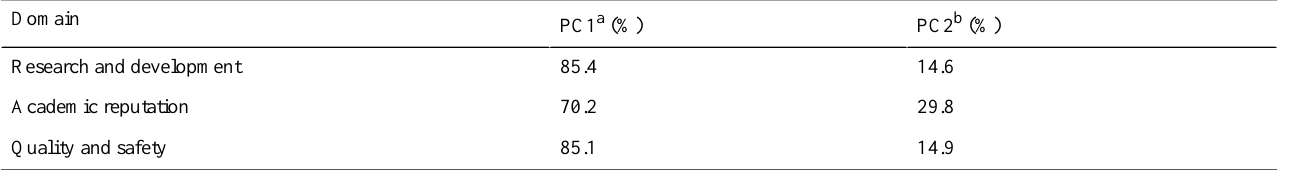
Table 5. Results of the entropy weight method for the three domains of the China Hospital Development Index.